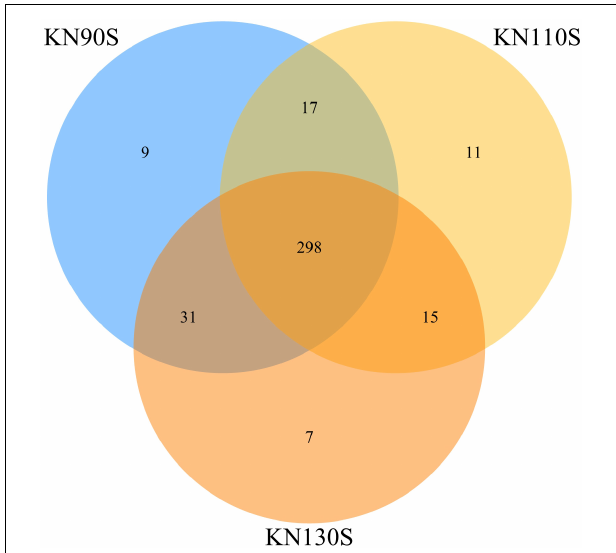
FIGURE 1 | Venn diagram of the core OTUs of king grass silage (KN90S, king grass silage harvested at growth periods of 90 days; KN110S, king grass silage harvested at growth periods of 110 days; KN130S, king grass silage harvested at growth periods of 130 days; OTU, operational taxonomic unit).